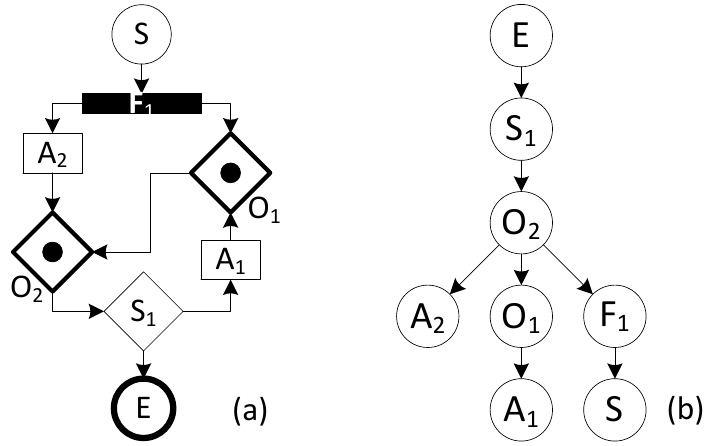
Figure 7. The workflow graph (a) of Figure 5 and its post-dominator tree